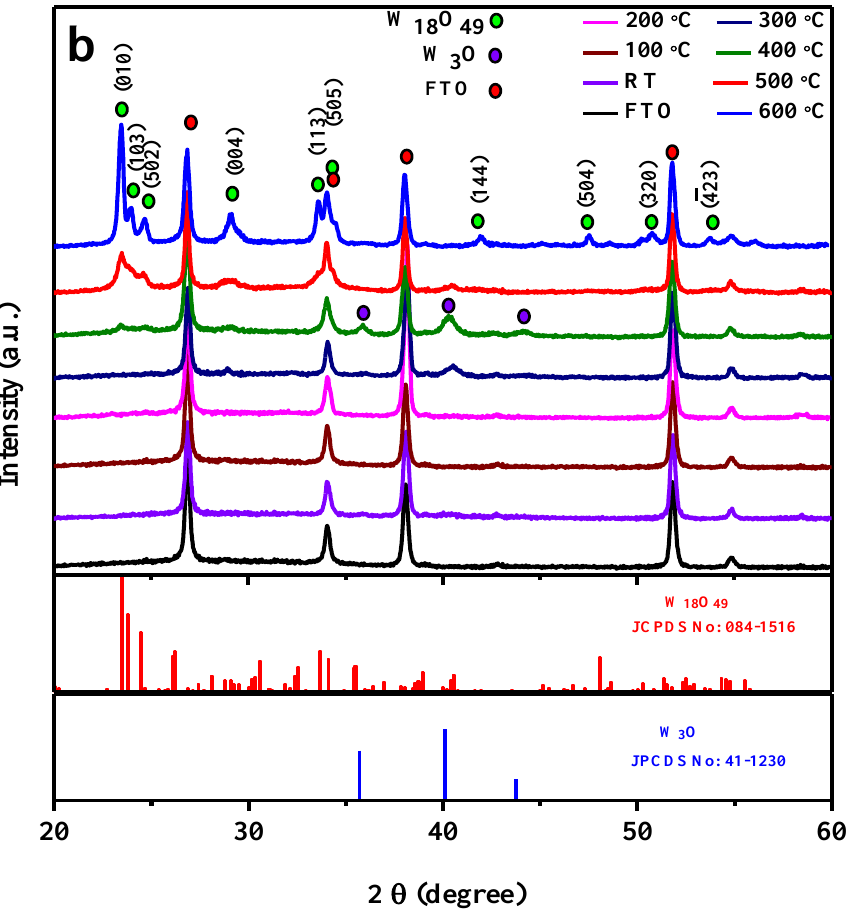
Figure 1. X-ray diffraction (XRD) patterns of the ( a ) W 18 O 49 films with various thickness fabricated by post-annealing of sputtered W film at 500 °C in air ( b ) metallic W film to W 18 O 49 phase transformation as a function of post-annealing treatment.